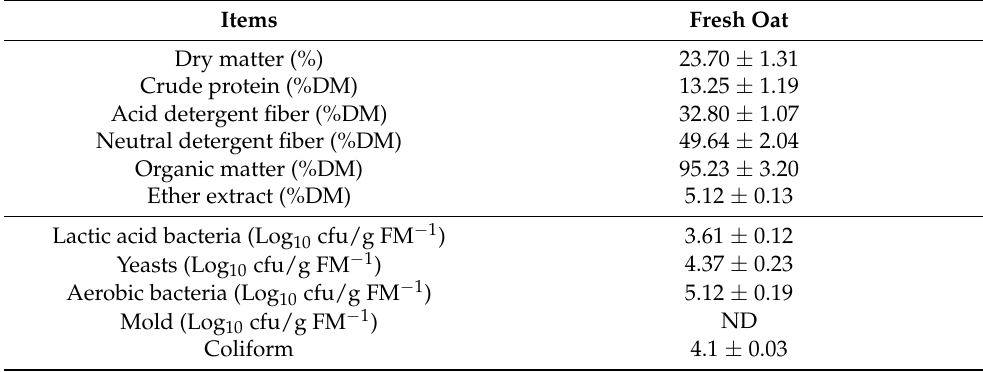
Table 1. Chemical composition and microbial population of fresh oat.